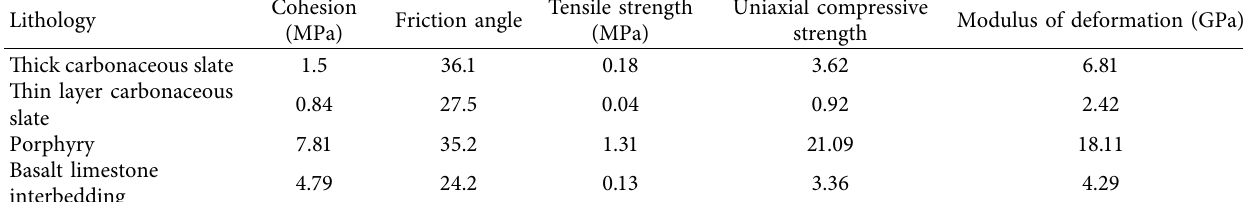
Table 2: Rock mass strength parameters based on GSI classification